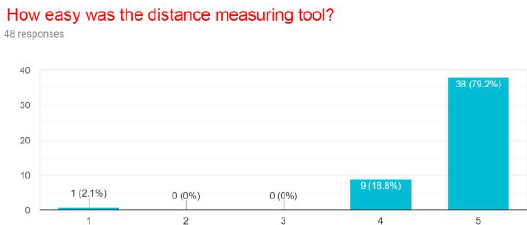
Figure 14: User response on the usability of the distance tool